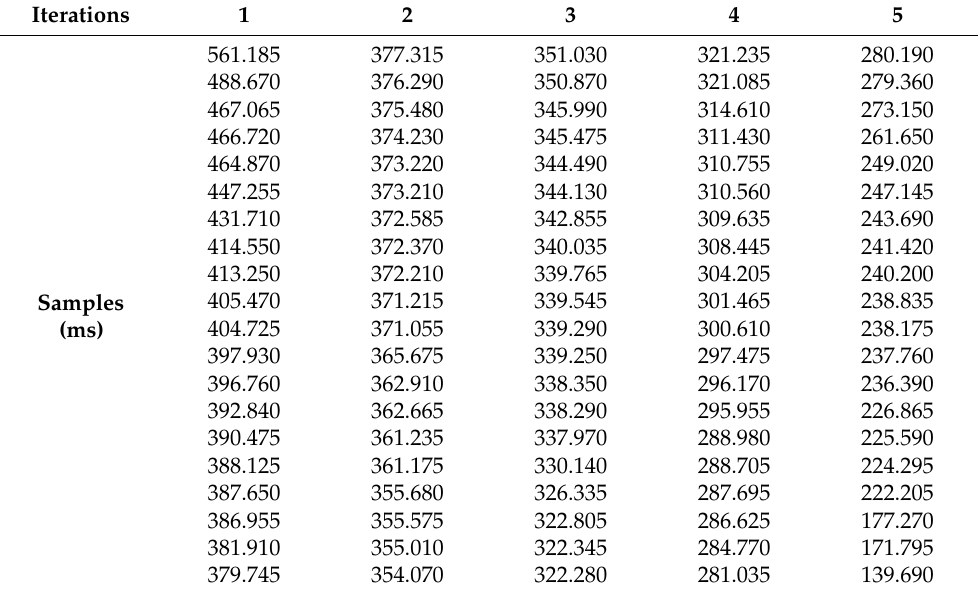
Table 8. Samples collected for Test 2, which represent the user reaction timing after the detection of a marker, sorted from highest to lowest, divided into 5 groups of 20